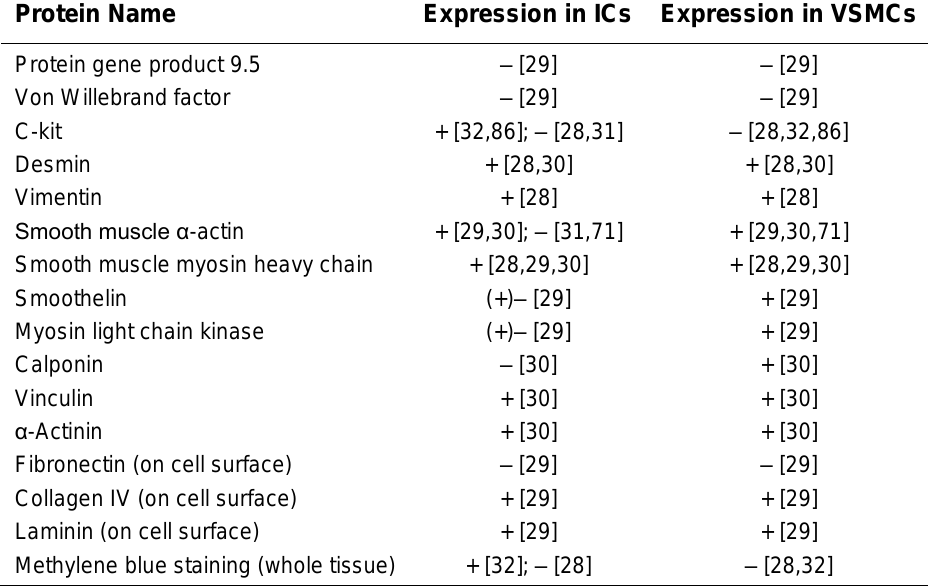
Expression of Proteins by Vascular ICs and